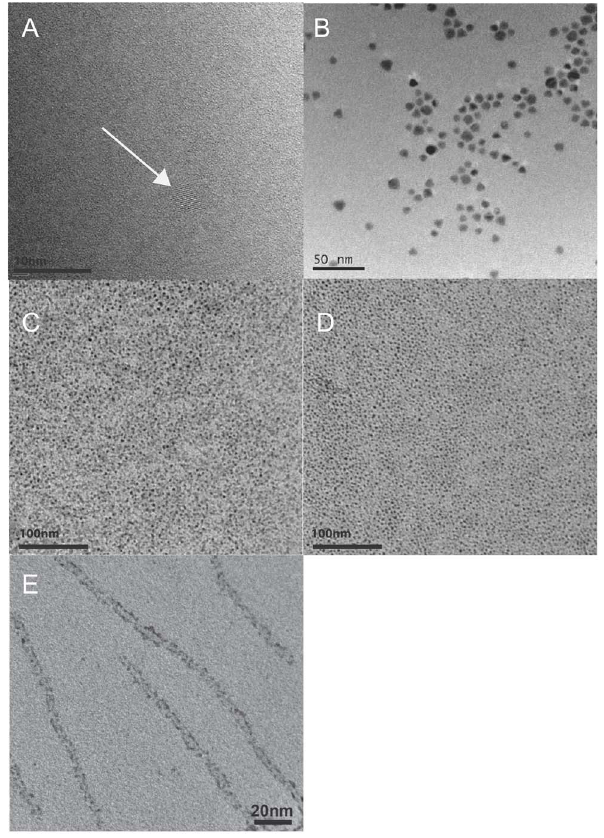
Figure 1. Transmission Electron Micrographs (TEM) of nano- particles show that nanoparticle cores range from 3–9 nm. (A) High-resolution TEM of silicon nanoparticles functionalized with undecylenic acid, arrow points to Si crystalline structure; (B) Cadmium selenide nanoparticles functionalized with undecylenic acid; (C) Titanium dioxide nanoparticles functionalized with polyacrylic acid; (D) Zinc oxide nanoparticles functionalized with polyacrylic acid; (E) Helical rosette nanotubes functionalized with